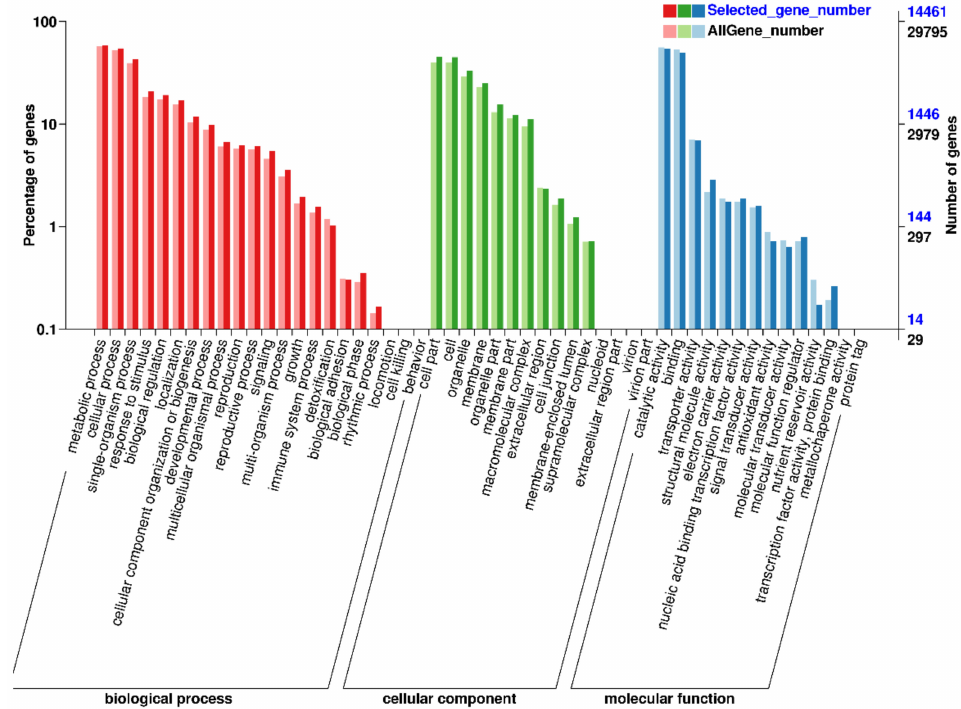
Figure 3. GO classification of unigenes from pink Camellia sinensis flower.